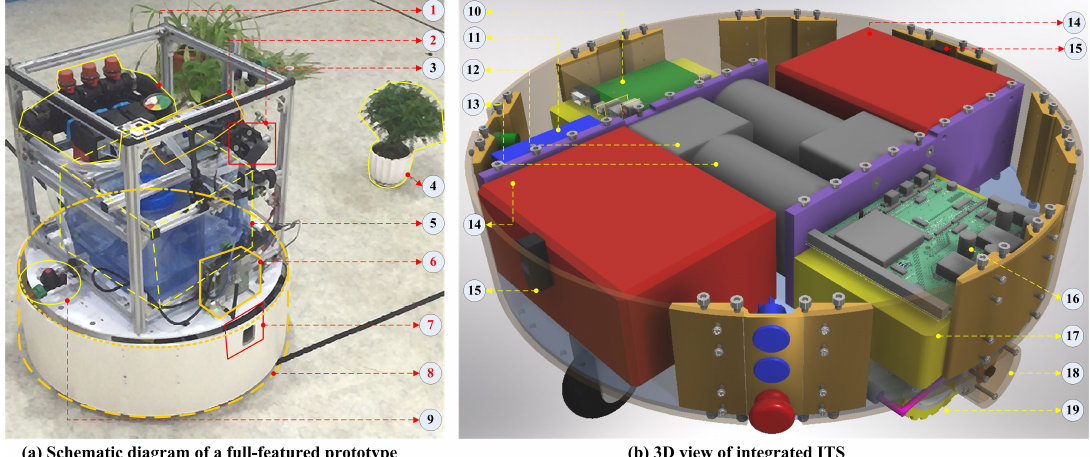
Figure 10. An ITS instance for greenhouse spraying